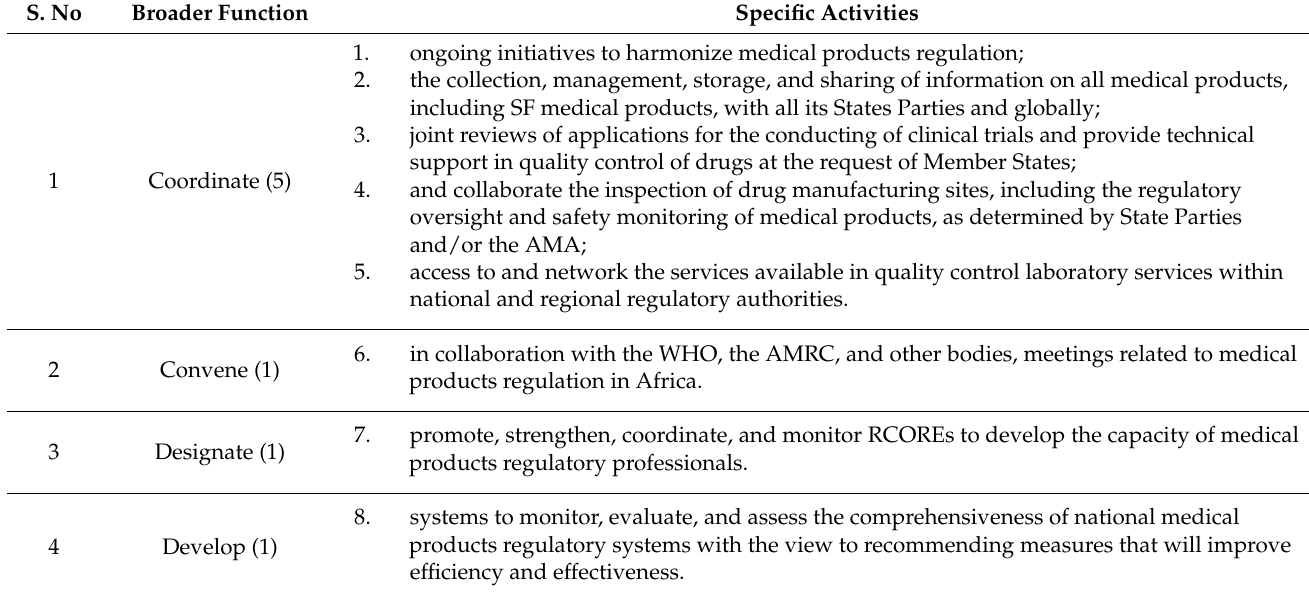
Table 1. Main Functions of African Medicines Agency as per the